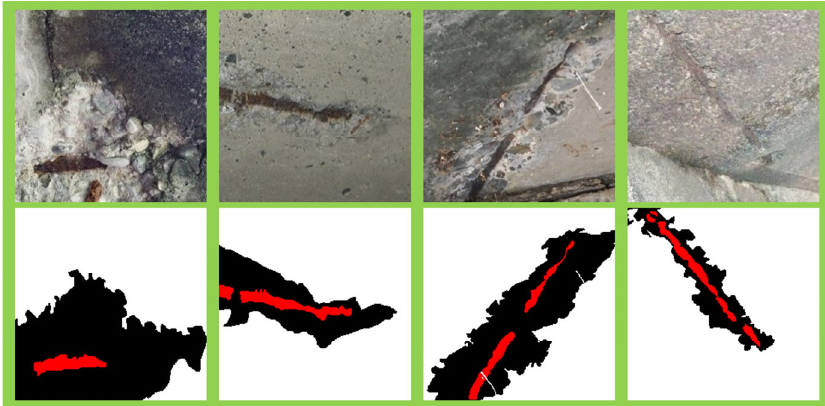
Figure 5. Example of a pair of images and label data from dataset B.